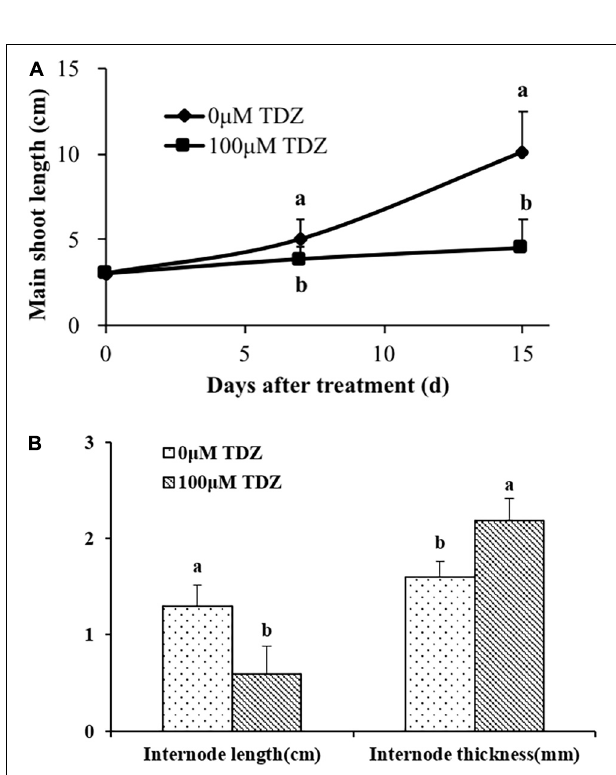
FIGURE 3 | Effects of application of 100 µ M TDZ on shoot length (A) and the third internode length and thickness (B) of miniature rose plants 2 weeks after treatment. Means ( ± SE, n = 16) with different letters are significantly different at P ≤ 0.05.